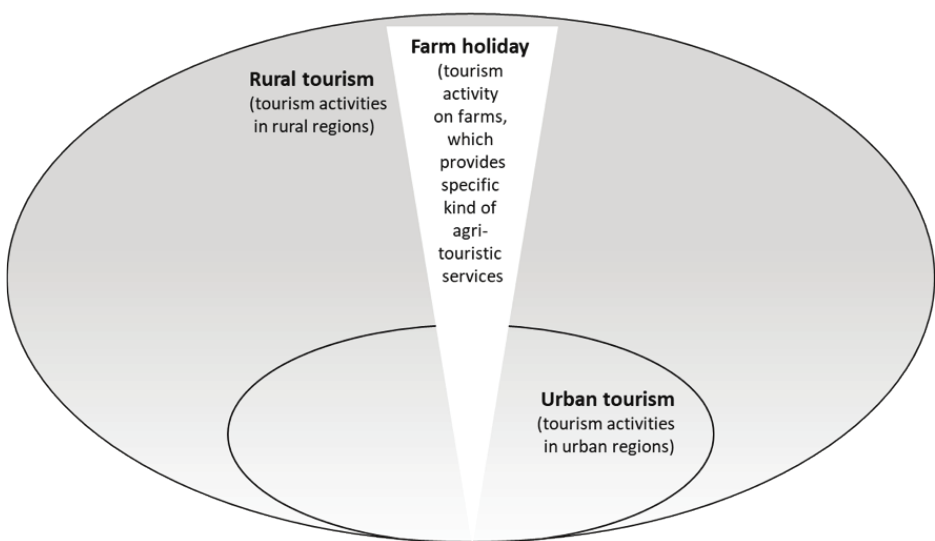
Figure 1: The ‘farm holiday’ within the tourism sector (own illustration based on UNWTO 1994: 5 and UNWTO